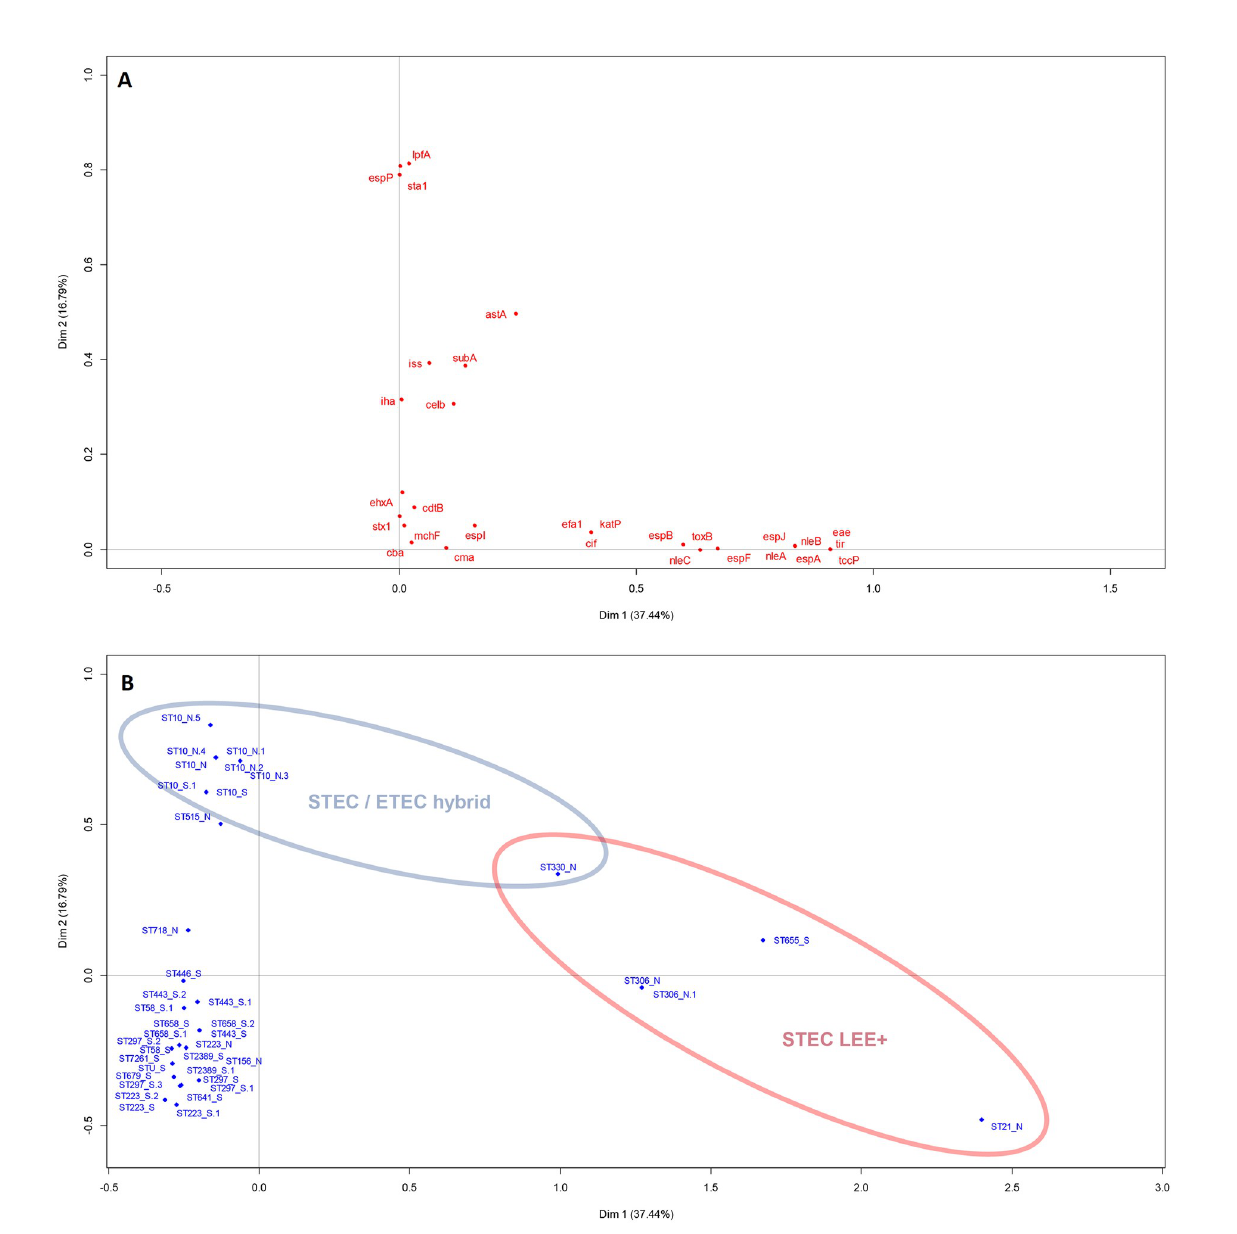
Fig 4. Multiple correspondence analysis biplots of the virulence genes of stx 2a -positive E . coli from Norwegian and Swedish cattle. Association between virulence genes is estimated based on co-occurence in isolates (A), and association between isolates is estimated based on the genes they possess or lack